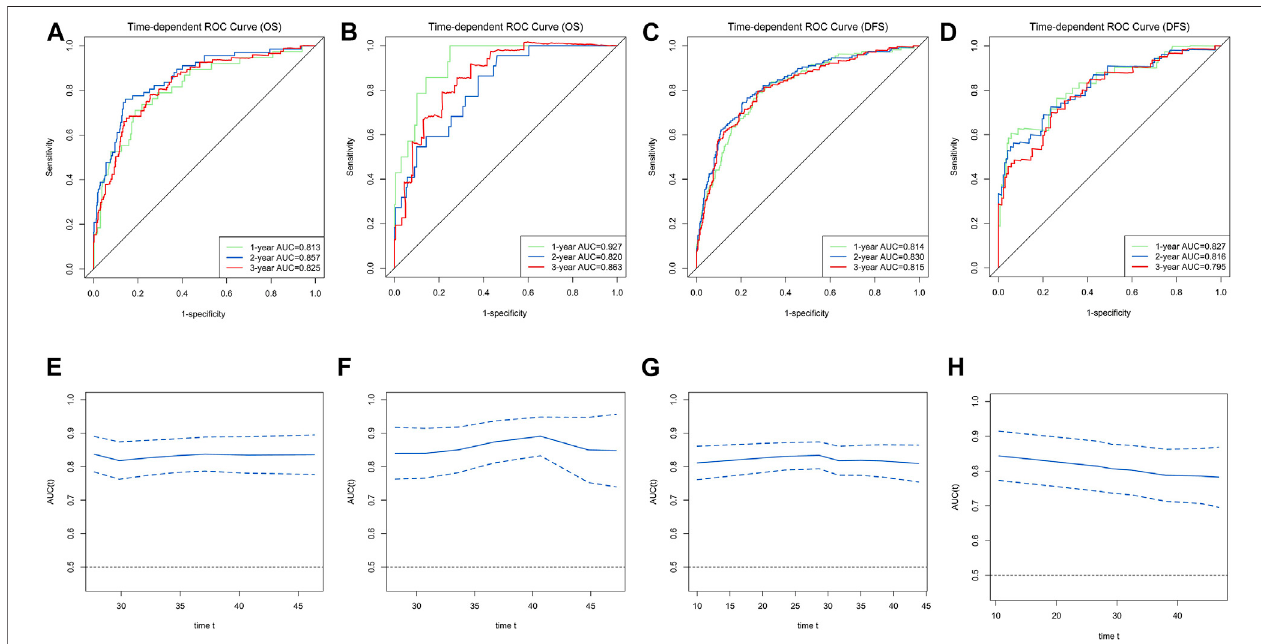
FIGURE2| Time-dependentreceiver operating characteristic (ROC) curvesfortheoverallsurvival(OS)and disease-free survival(DFS)-associated nomogramsfor predicting 1-, 2-and 3-yearsurvivalrates and time-AUCs ofthemodel. Time-dependentROC curves from the nomogramsforthe prediction ofOSand DFS ratesin the training (A,C) and testing (B,D) sets. Time-AUCs from the nomograms for the prediction of OS and DFS rates in the training (E,G) and testing (F,H) sets.